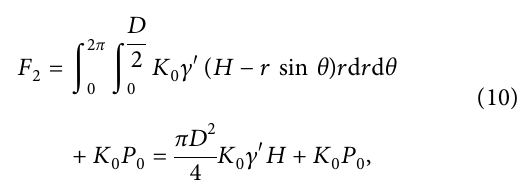
Figure 3: Force analysis of the shield